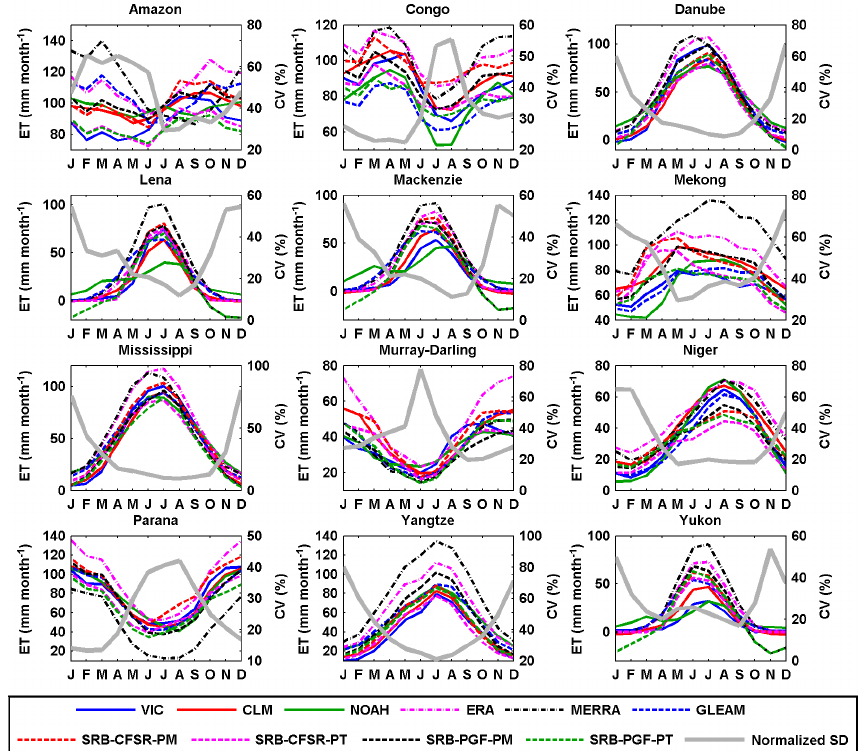
Figure 5. Seasonal cycles of evapotranspiration from different products over 12 representative large basins for